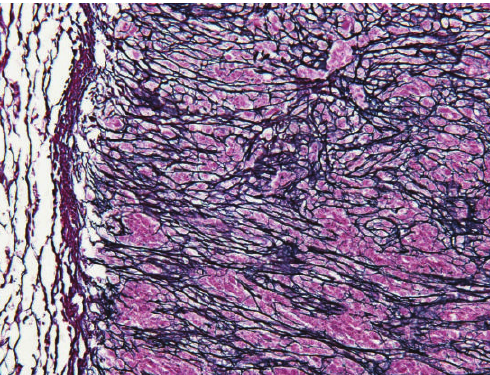
Figure 4: In silver stain, the nodule showed trabecular pattern alignment of ghost cells and reticulin fibers orthogonal to the capsule, which was similar to the hepatocyte-originated neoplasm.